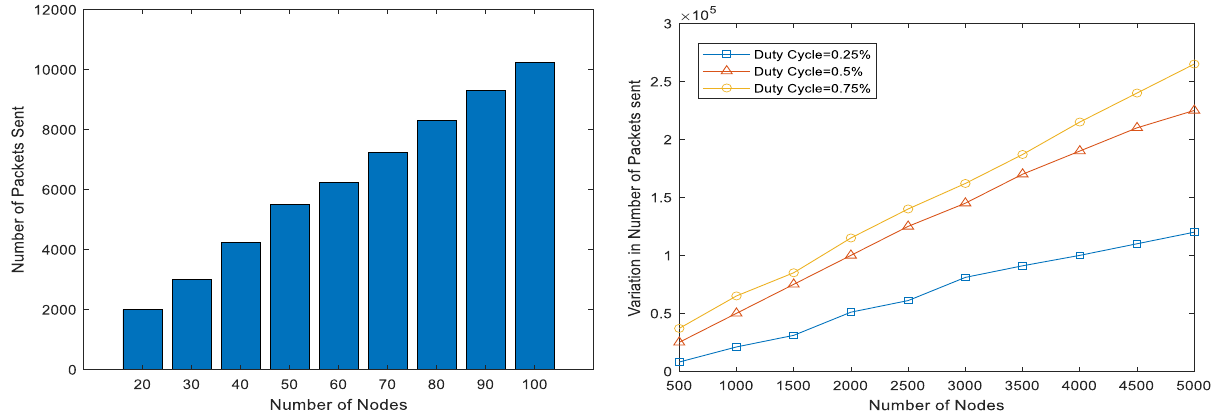
Figure 1: Number of packets sent from di ff erent number of nodes.